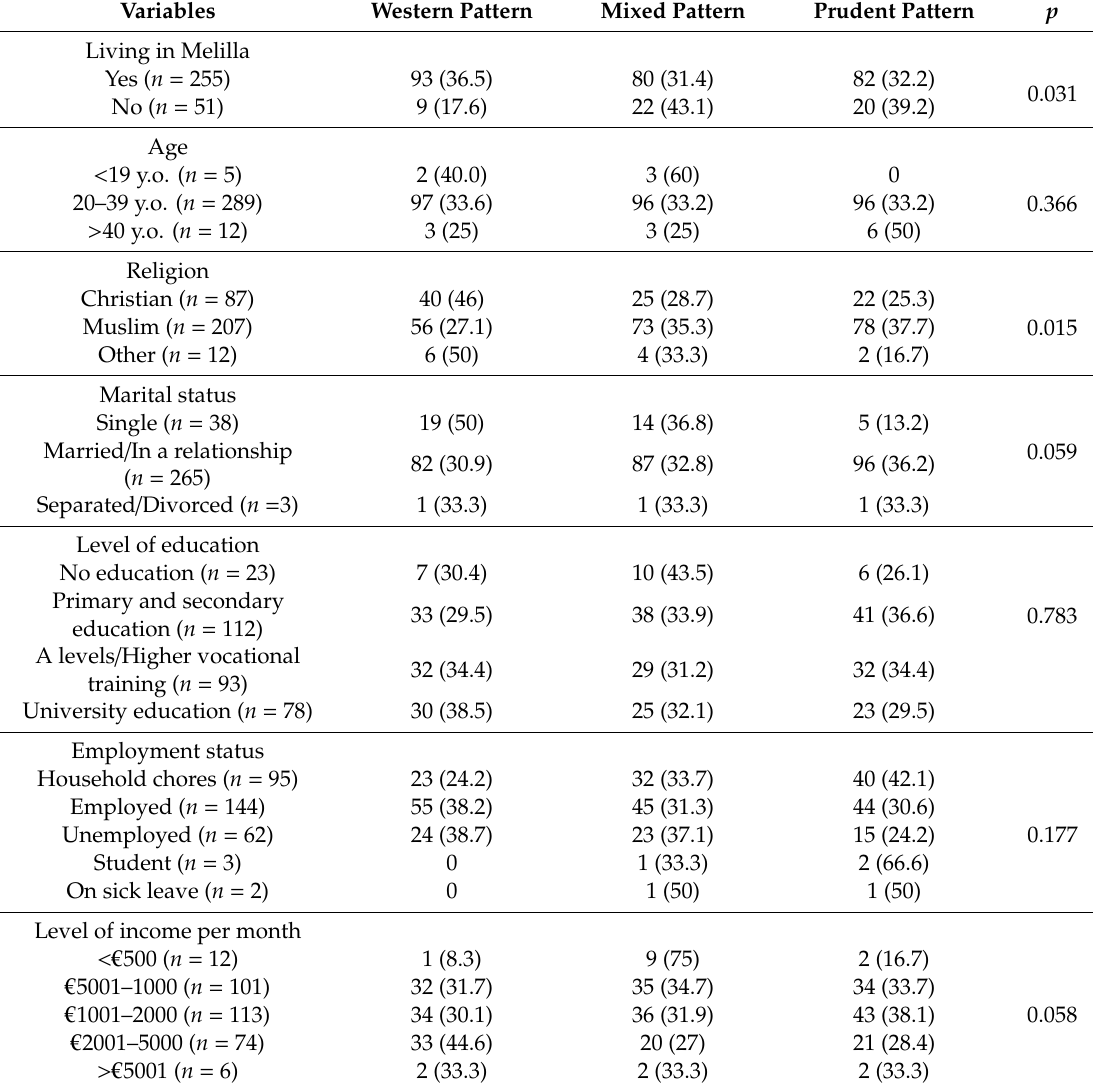
Table 5. Sociodemographic, lifestyle-related, and pregnancy-related variables and dietary patterns ( N = 306)